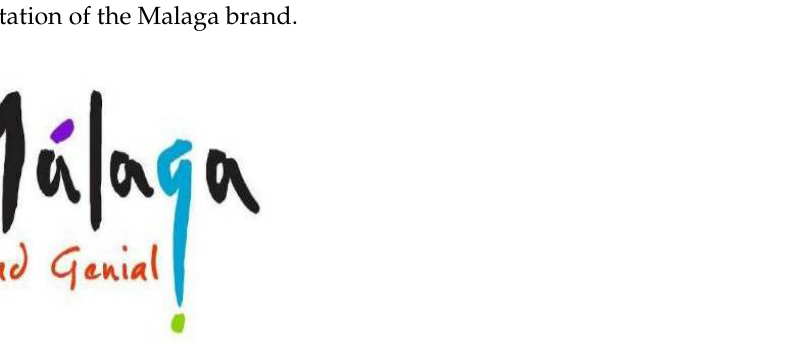
Figure 5. Do you know the brand Malaga? Source: own elaboration.